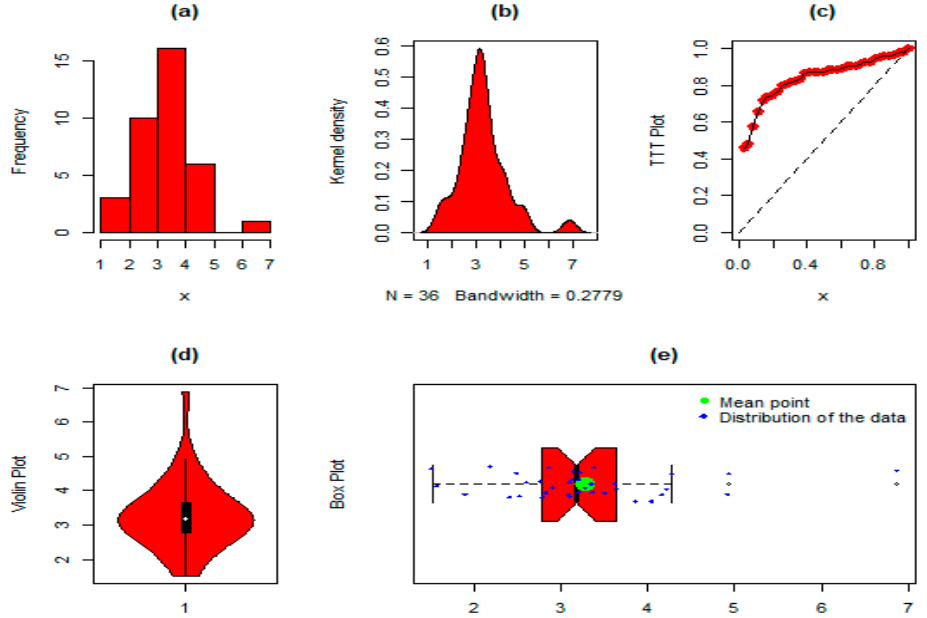
Figure 8. For dataset 3, the ( a ) histogram, ( b ) kernel density plot, ( c ) TTT plot, ( d ) violin plot, and ( e ) box plot.